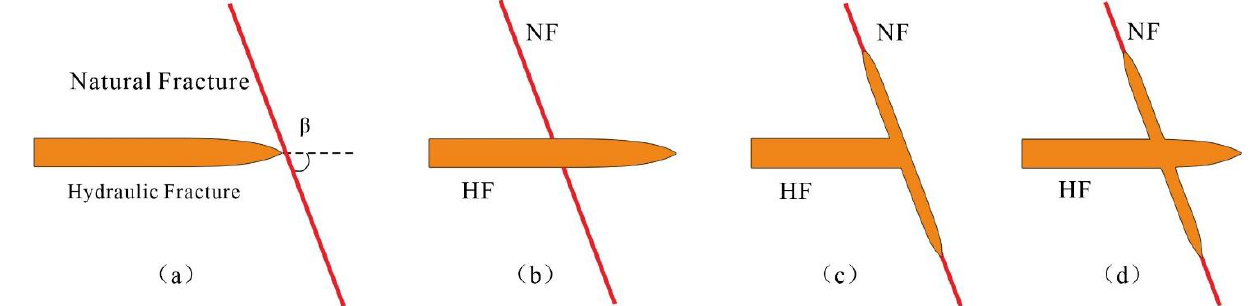
Figure 7. Results of the interaction between hydraulic cracks and natural cracks [117]: ( a ) Cut-off, ( b ) Penetration, ( c ) Deflection, ( d ) Bifurcate. ( b ) Penetration, ( c ) Deflection, ( d )